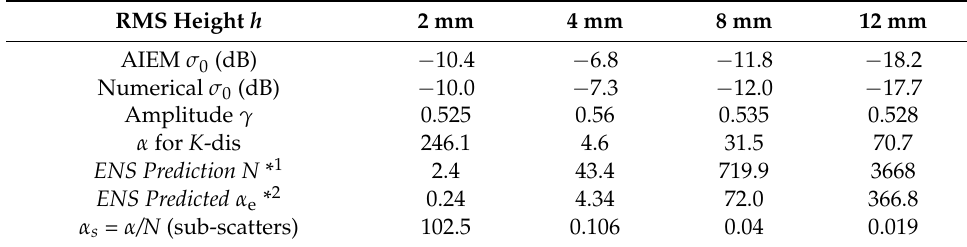
Figure 16. PDF curves of FDTD-simulated backscattering amplitude at θ i = 30 ◦ , considering exponentially correlated surface with different h , ( a ): h = 2 mm; ( b ): h = 4 mm; ( c ): h = 8 mm; ( d ): h = 12 mm. VV, compared with referencing Rayleigh distribution and K -distribution, 1600 realizations. Sample and computation parameters are in Tables 1 and 3(set 2). Table 7. Comparisons of the average intensity values and amplitude speckle values from simulated backscattering results by 1600 realizations, at the footprint size of 30 mm (3.2 λ , 0.63 l ), Sample and computation parameters are in Tables 1 and 3(set